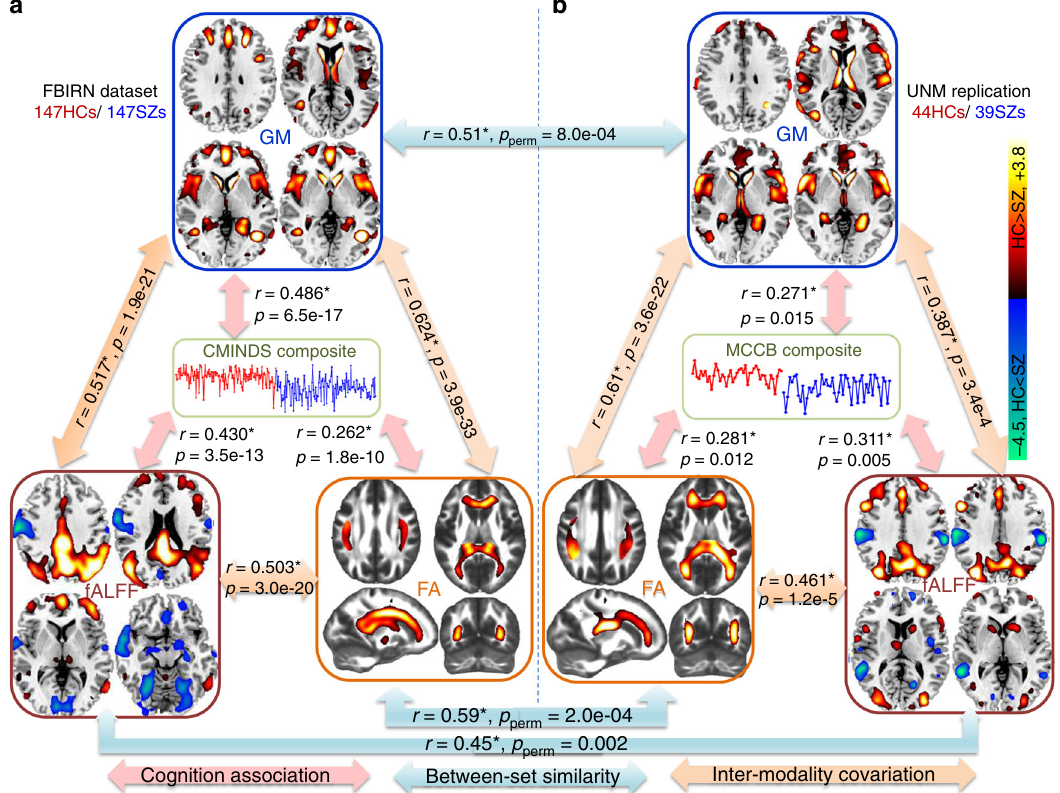
Fig. 3 Similarity and co-varying patterns of the identi fi ed multimodal networks between cohorts. a The identi fi ed multimodal networks associated with the CMINDS composite score in the FBIRN cohort. b The identi fi ed multimodal networks associated with the MCCB composite score in the UNM cohort. The brain maps were visualized at | Z | > 2. The blue arrows represent the cross-cohort spatial correlation ( p perm are p values from a permutation test using 10,000 randomizations); the orange arrows represent inter-modality covariation across subjects; and the pink arrows denote the correlations between cognitive composite score (the reference) and the identi fi ed IC